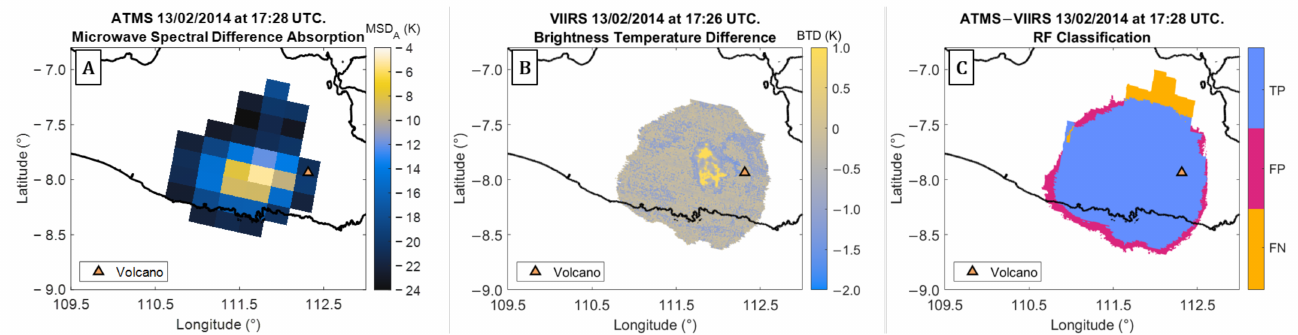
Figure 8. The Kelud eruption on 13th February 2014. ( A ) The volcanic cloud detected by using the MSD decision rule. ( B ) The volcanic cloud detected by the BTD decision rule. ( C ) The RF classification where purple pixels are correctly classified ash pixels, magenta pixels are false alarms and orange pixels represent missed ash